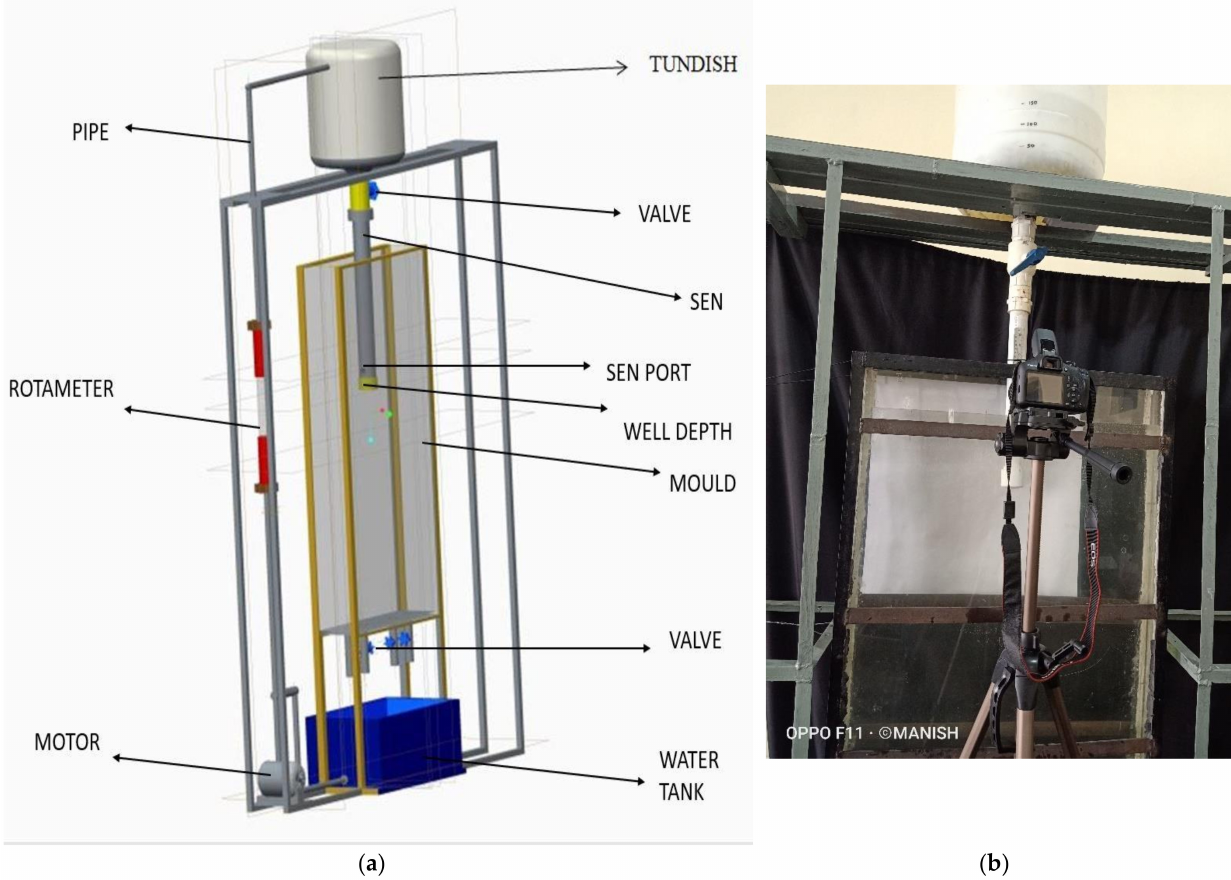
Figure 1. ( a ) Pictorial view of the water model experimental setup. ( b ) Experimental setup at the Department of Mechanical Engineering, Birla Institute of Technology, Mesra (Ranchi),